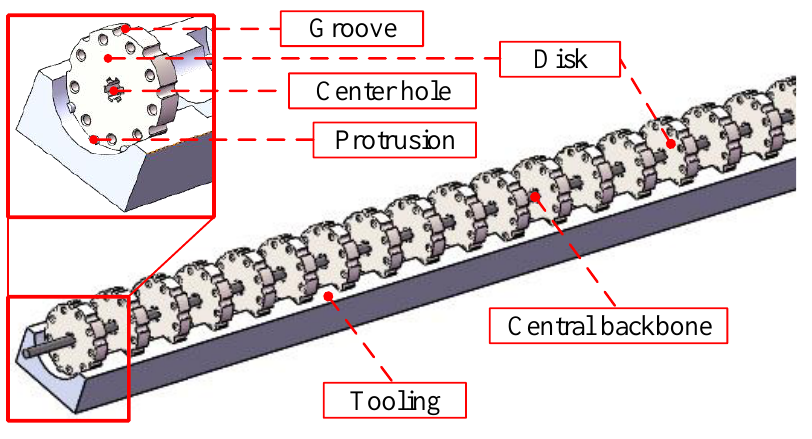
Figure 3. The schematic of the tooling.